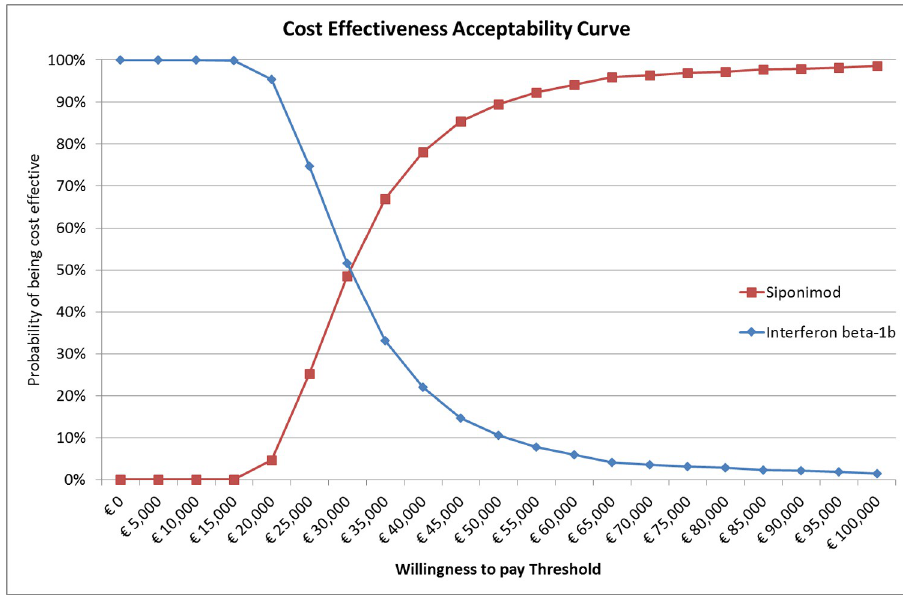
Fig 3. PSA analysis of siponimod compared with interferon